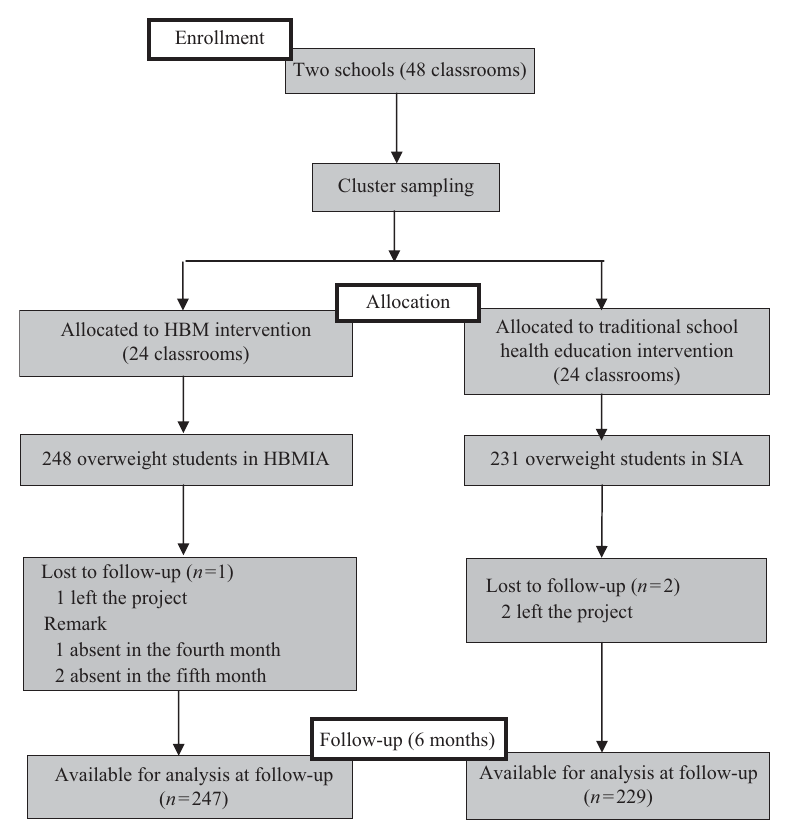
Figure 1. Participant flow